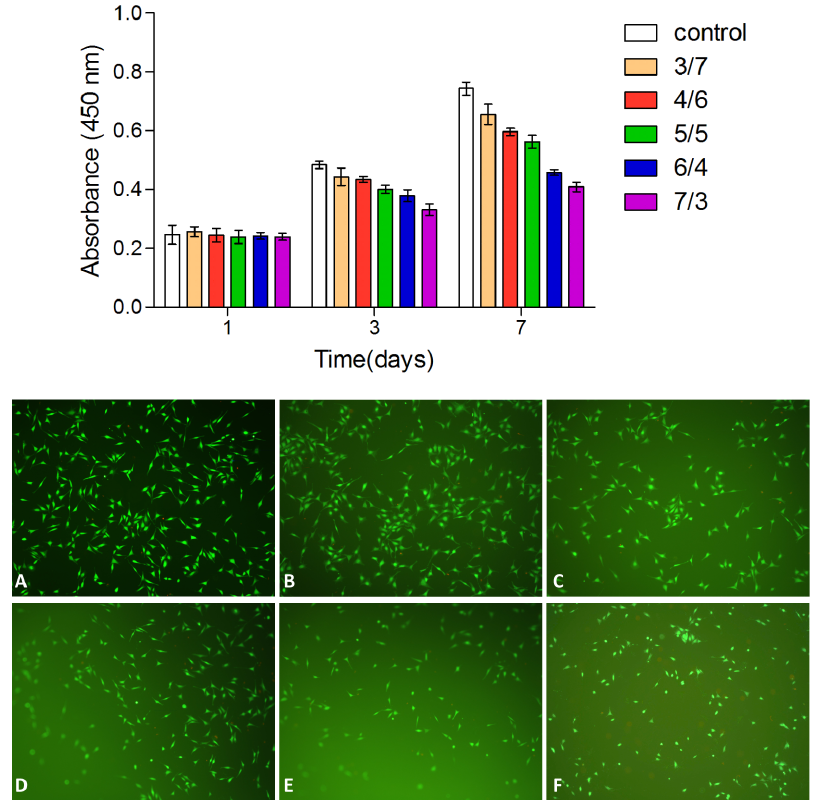
Figure 10. The proliferation of cells cultured on dextran/gelatin hydrogels in the CCK-8 assay: the absorbance of these medium with CCK-8 was read at 450 nm. Cells cultured on the hydrogels were stained with Live/Dead staining solution (A: tissue culture plate; B: 3/7; C: 4/ 6; D: 5/5; E: 6/4; F: 7/3).